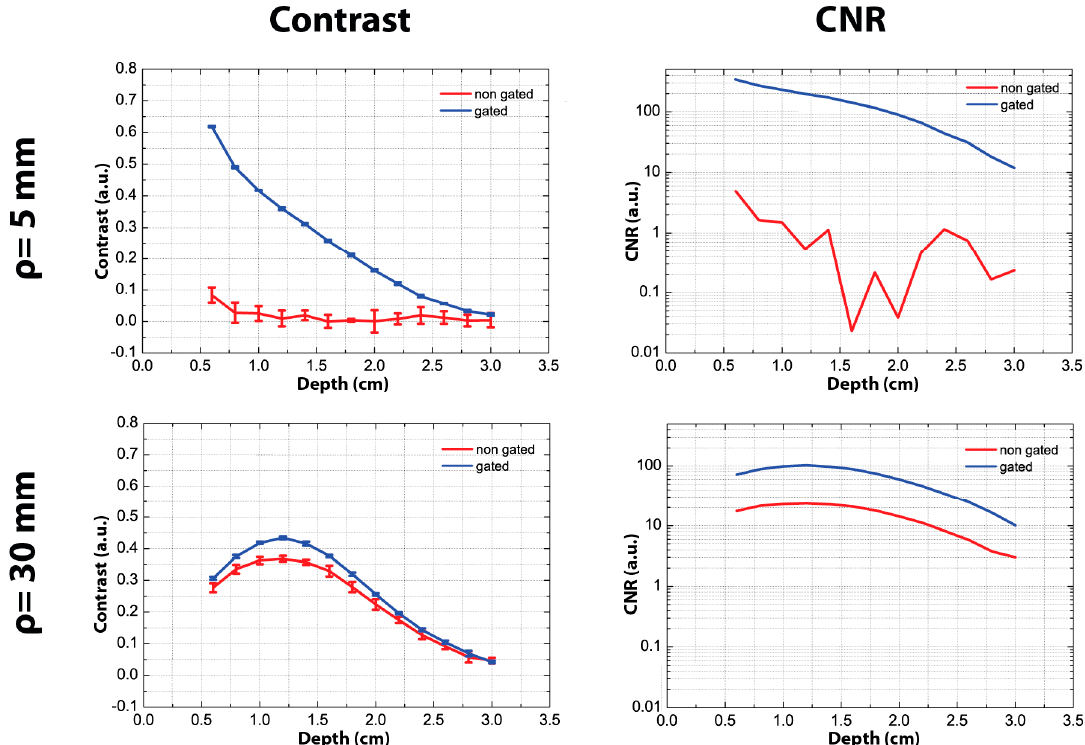
Figure 2. Contrast (left column) and contrast-to-noise ratio (CNR) (right column) computed at two different source-detector distances (5 mm, top row; 30 mm, bottom row) with and without the exploitation of the fast-gating technique (blue and red curves, respectively).